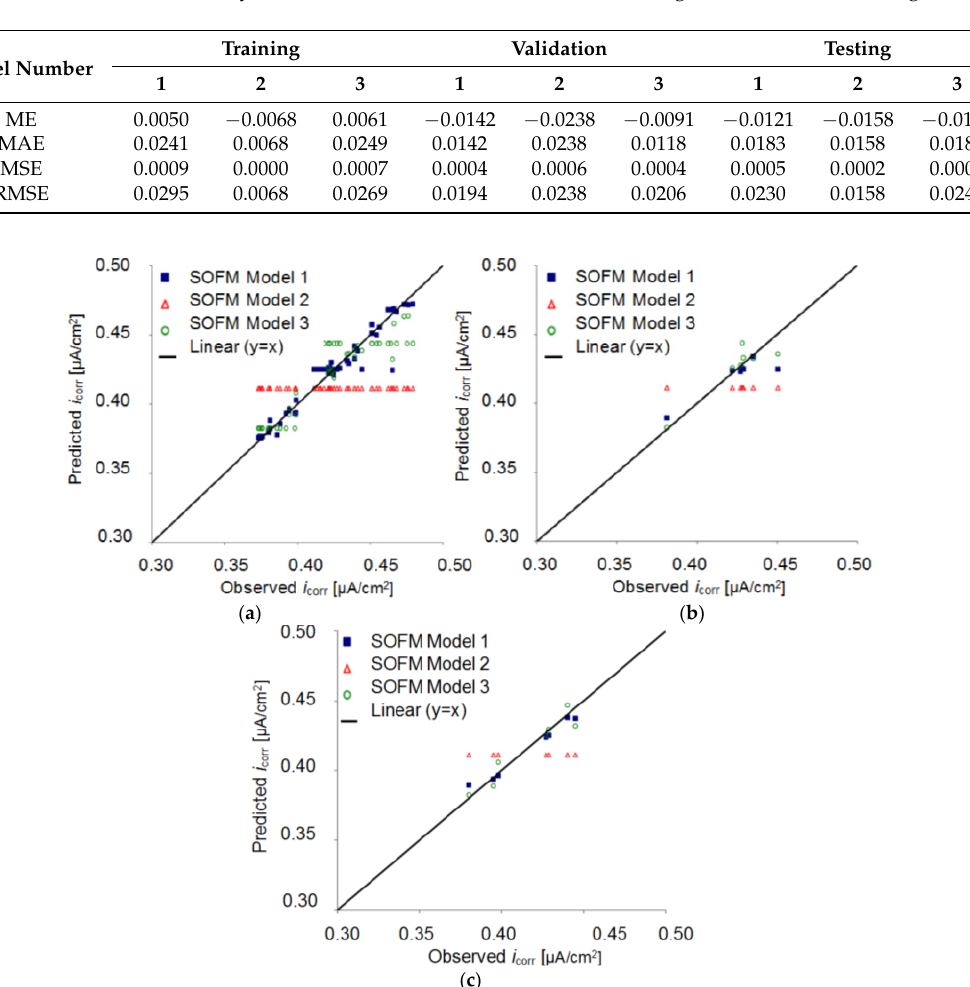
Figure 5. Corrosion current density prediction using the different SOFM models in the processes of ( a ) training, ( b ) validation, and ( c ) testing.